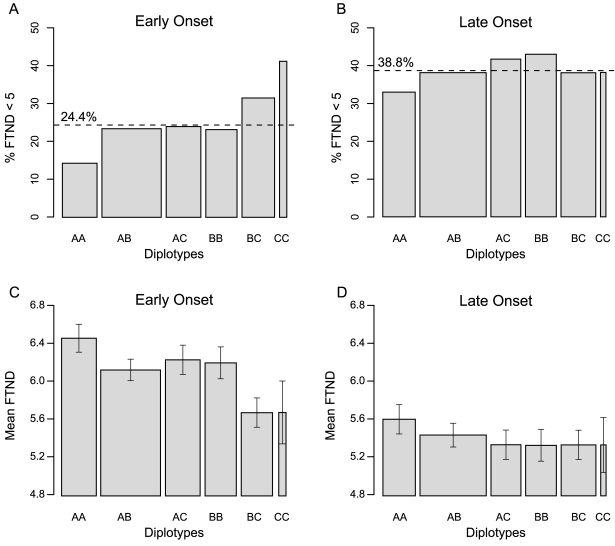
Low Nicotine Dependence (%) and Mean FTND Scores by Diplotype and Age of Onset of Daily Smoking in the Combined UT-WI-LHS Cohorts.(A), (B) partitioning of diplotypes between FTND<5 and FTND>5 categories in early and late onset groups. The percentage of individuals in the FTND<5 category is shown by the dichotomous ‘FTND cut’ value (dashed line). (C), (D) mean FTND score of diplotypes by early and late onset; error bars indicate the S.E.M. Sample size by diplotype within the early onset condition was: AA, 161; AB, 276; AC, 162; BB, 146; BC, 153; and CC, 34. Within the late onset condition, diplotype sample sizes were: AA, 203; AB, 384; AC, 186; BB, 160; BC, 190; and CC, 34. Diplotype counts are indicated by the width of each associated column within the plots.